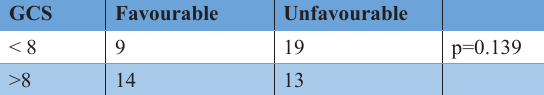
Table 7. Relation between preoperative GCS and outcome